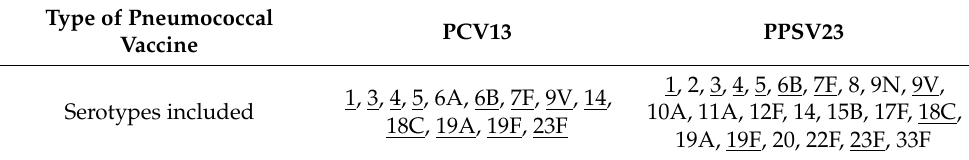
Table 1. Comparison of serotypes covered in both